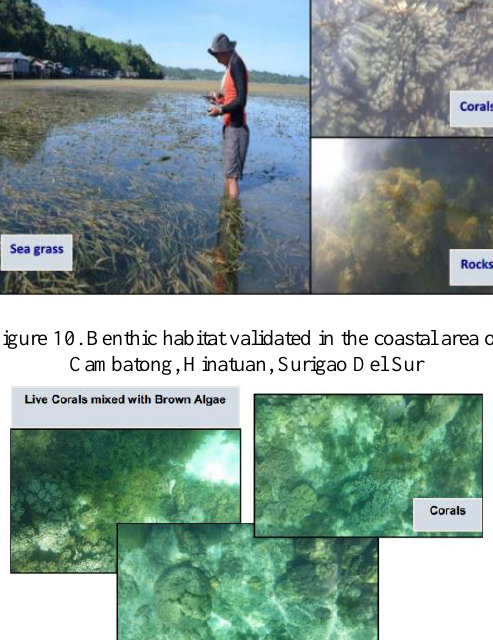
Figure 7. Sand and Sea Candidate